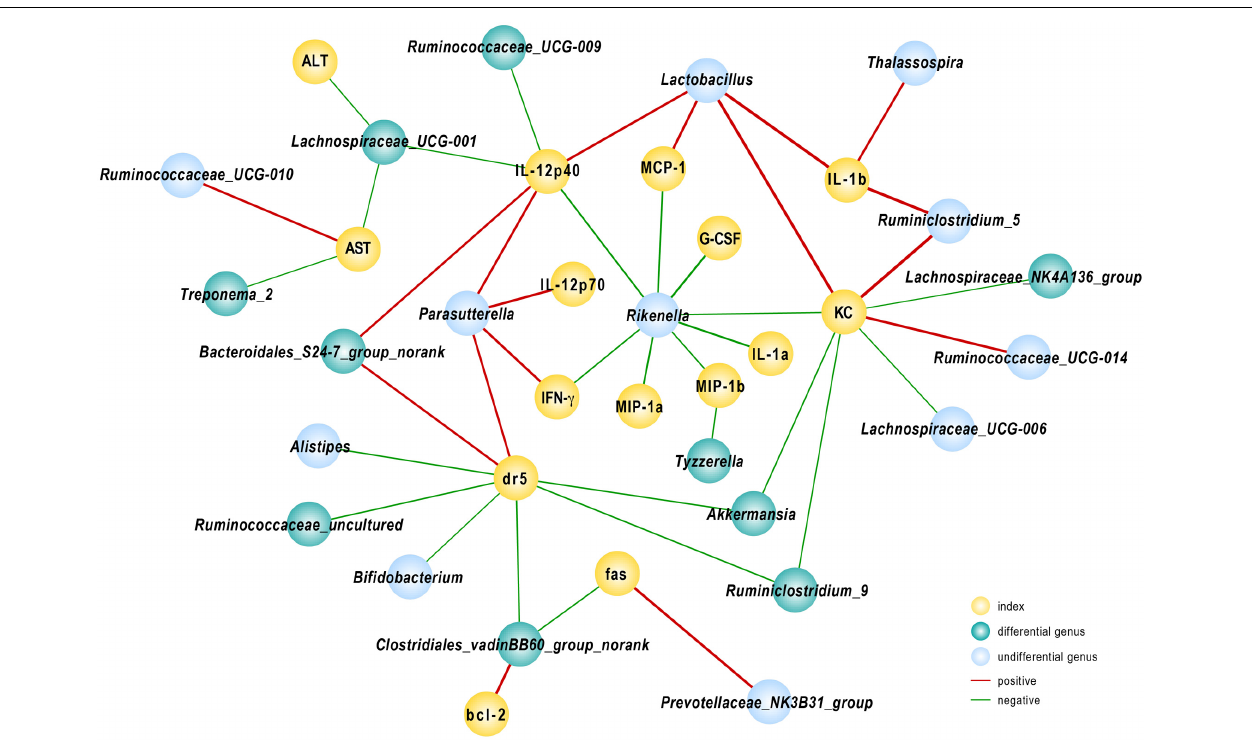
FIGURE 6 | Correlation analysis between gut microbiota and injury-related indexes. Spearman’s rho non-parametric correlation was used, and significant relationships with P < 0.05 and r > 0.5 are shown. Yellow nodes: injury-related indexes. Green nodes: differentially distributed genera between Control and Akk groups; blue nodes: the indexes showed differences but were not significantly different between the groups. Red lines between nodes represent positive relationships, and blue ones indicate negative linkages. The thickness of the connection represents the correlation coefficient, with thicker lines indicating higher r